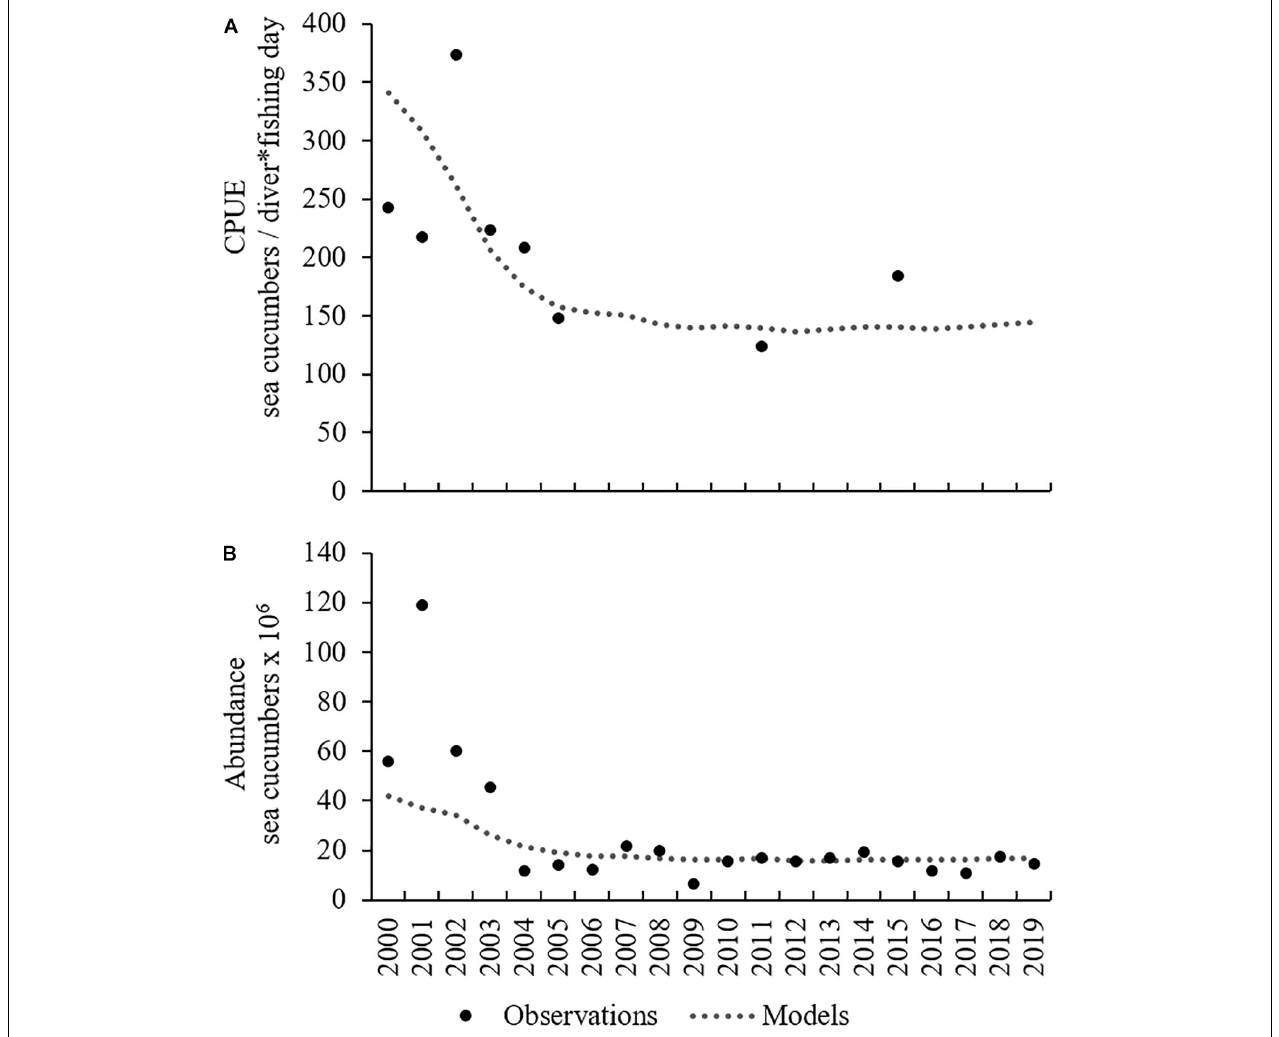
FIGURE 2 | Goodness-of-fit of ASPIC models of abundance (A) and CPUE (B) of I. fuscus in the GMR.